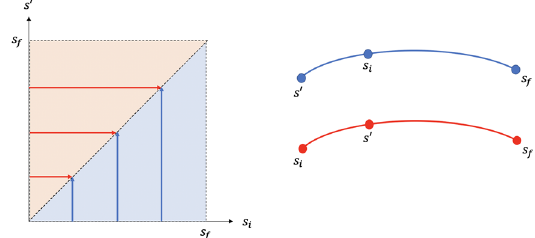
FIG. 11. Left: The change of the initial integration path (blue area) to the new path (red area). Right: The change of the variable orientation from the initial integration path (blue line) to the new path (red